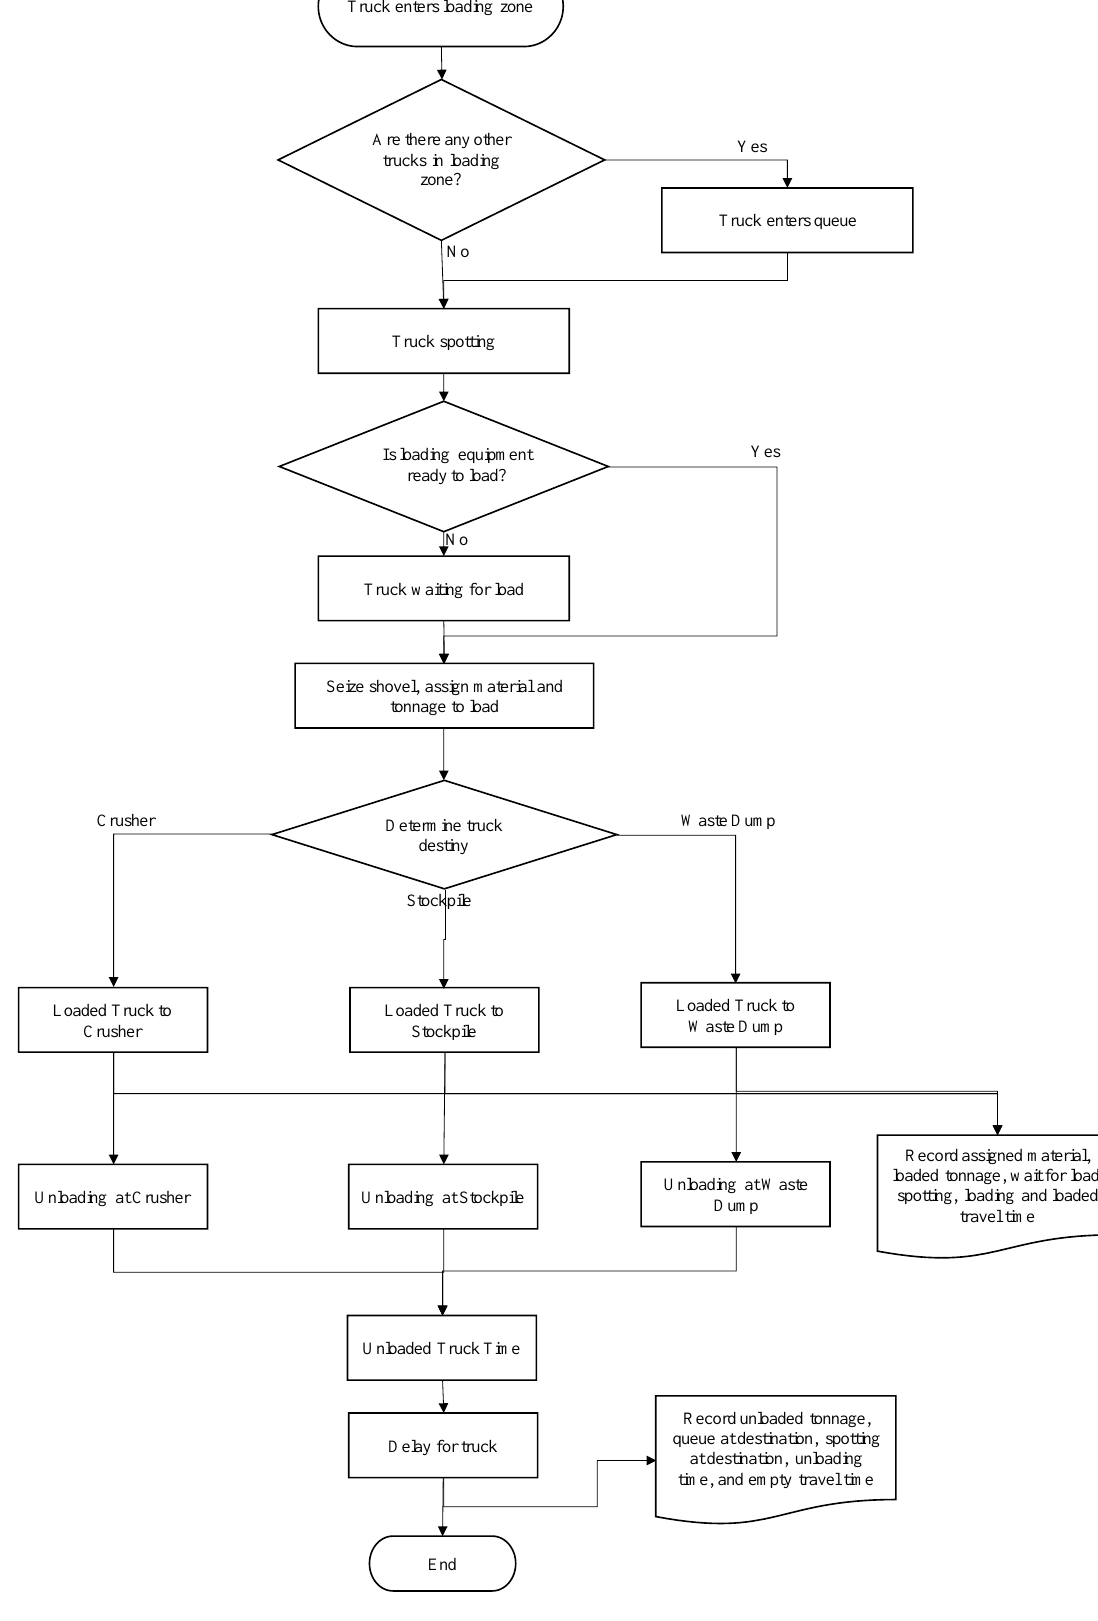
Figure 1. Calibration model flowchart.